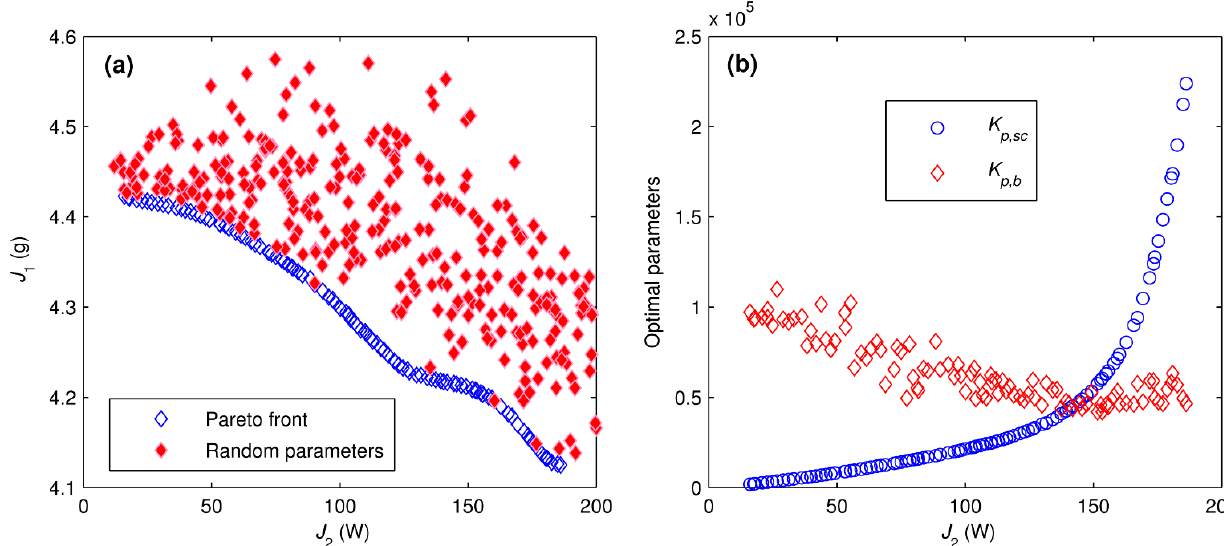
Figure 9. Optimization results of S1. ( a ) Comparison between the Pareto front and the performance of randomly tuned parameters; ( b ) Optimal strategy parameters for the Pareto